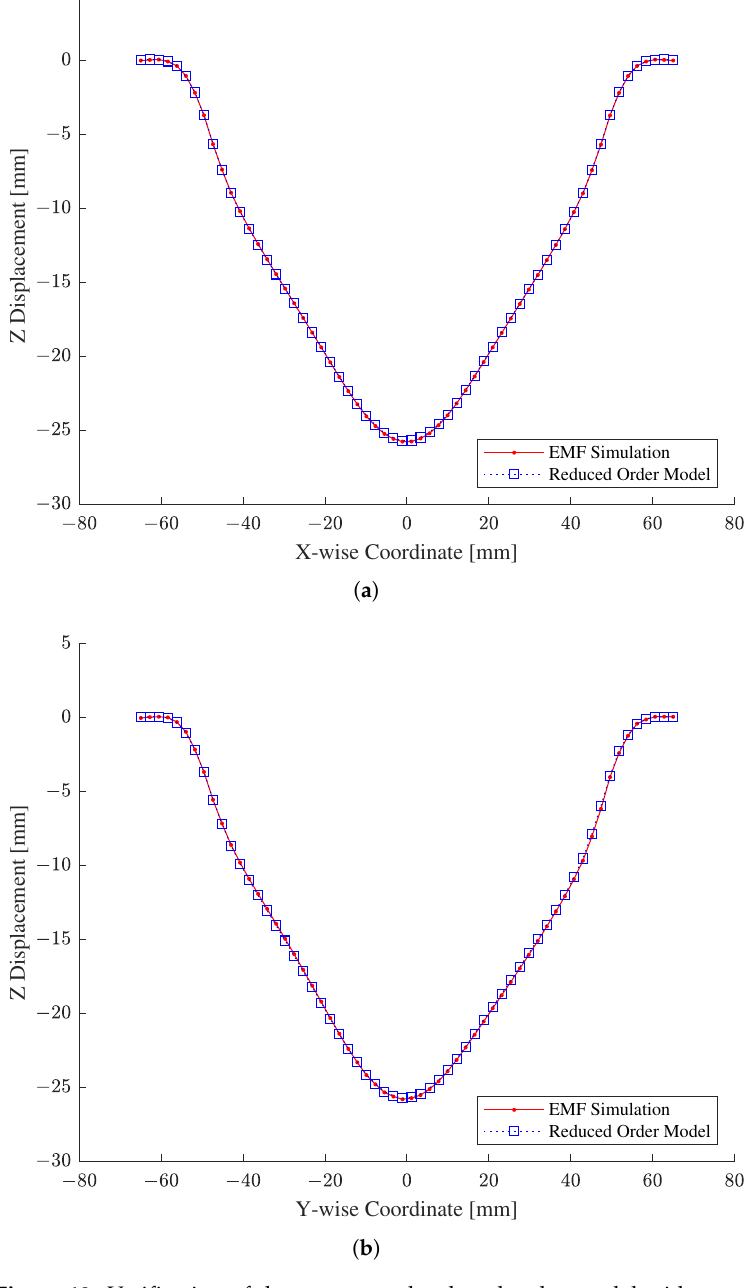
Figure 18. Verification of the constructed reduced order model with respect to the original EMF simulation. ( a ) X-wise coordinates. ( b ) Y-wise